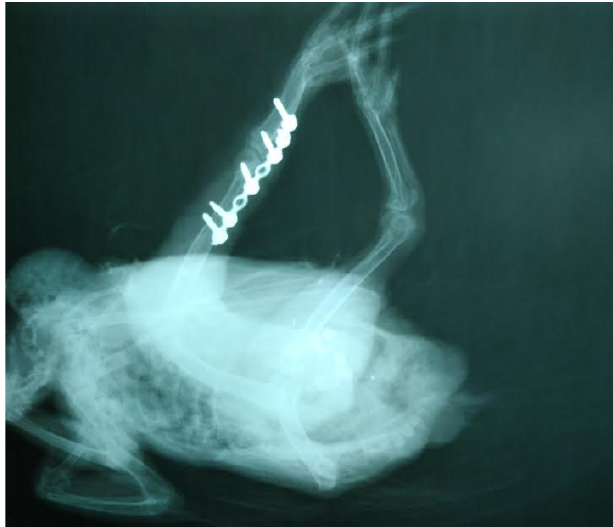
Fig. 2. Radiography showed 2.0 titanium maxillofacial plate was used for repair tibiometatarsal joint complete luxation